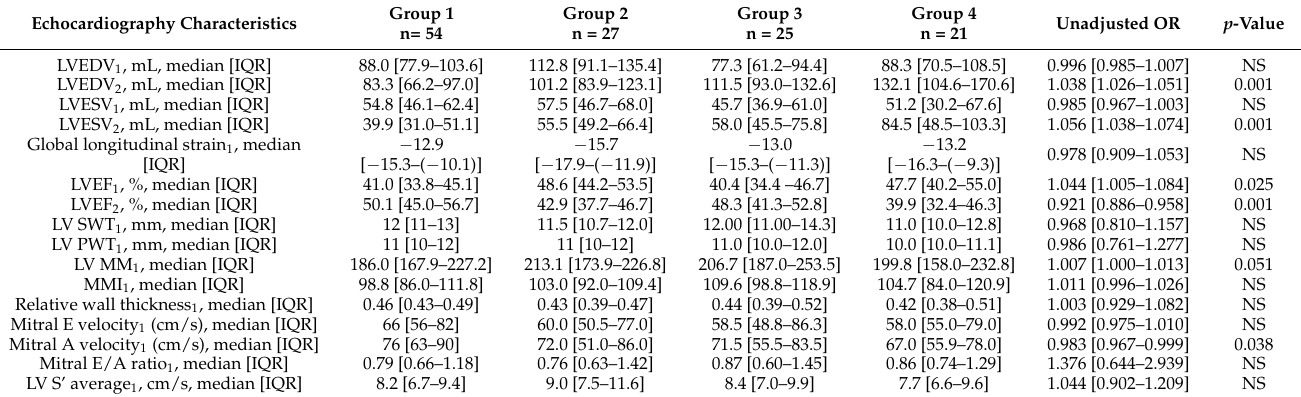
Table 2. Echocardiography characteristics of patients in the FLVR groups after